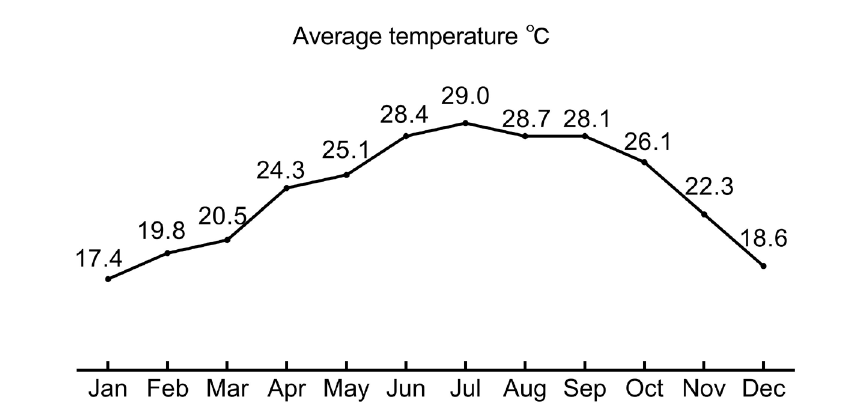
Figure 1 - The average temperature ( ℃ ) in Shenzhen region in 2019. Data were recorded from the Shenzhen Meteorological